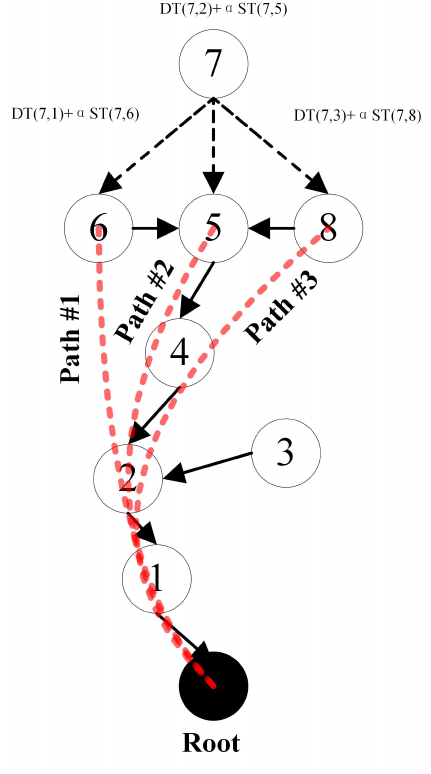
Figure 3. Example of searching optimal path for the point p 7 . Algorithm 1 Dynamic Path